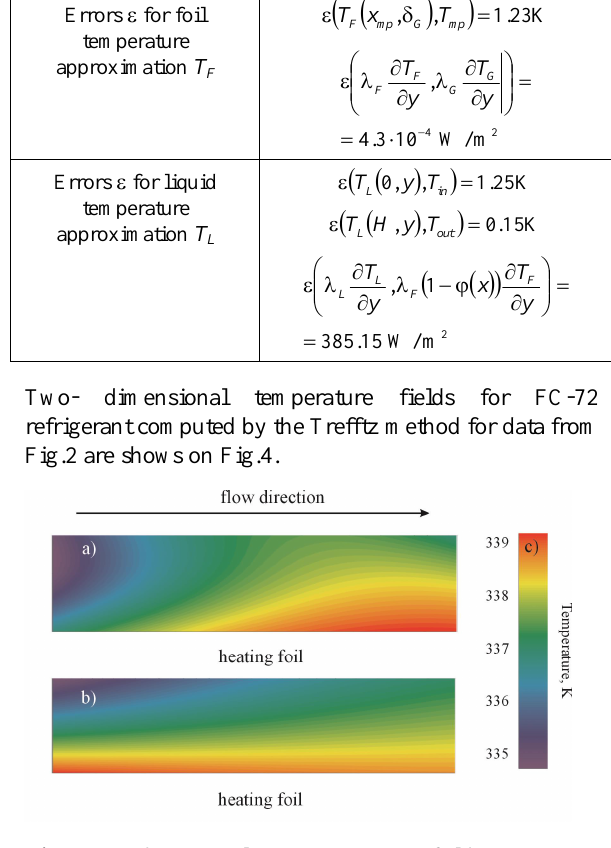
Fig. 4. Two-dimensional FC-72 temperature fields determined by the Trefftz method for a) q V =1.97·10 5 kW/m 3 , b) q V =2.01·10 5 kW/m 3 , c) scale. Additional data as in Fig. 2.